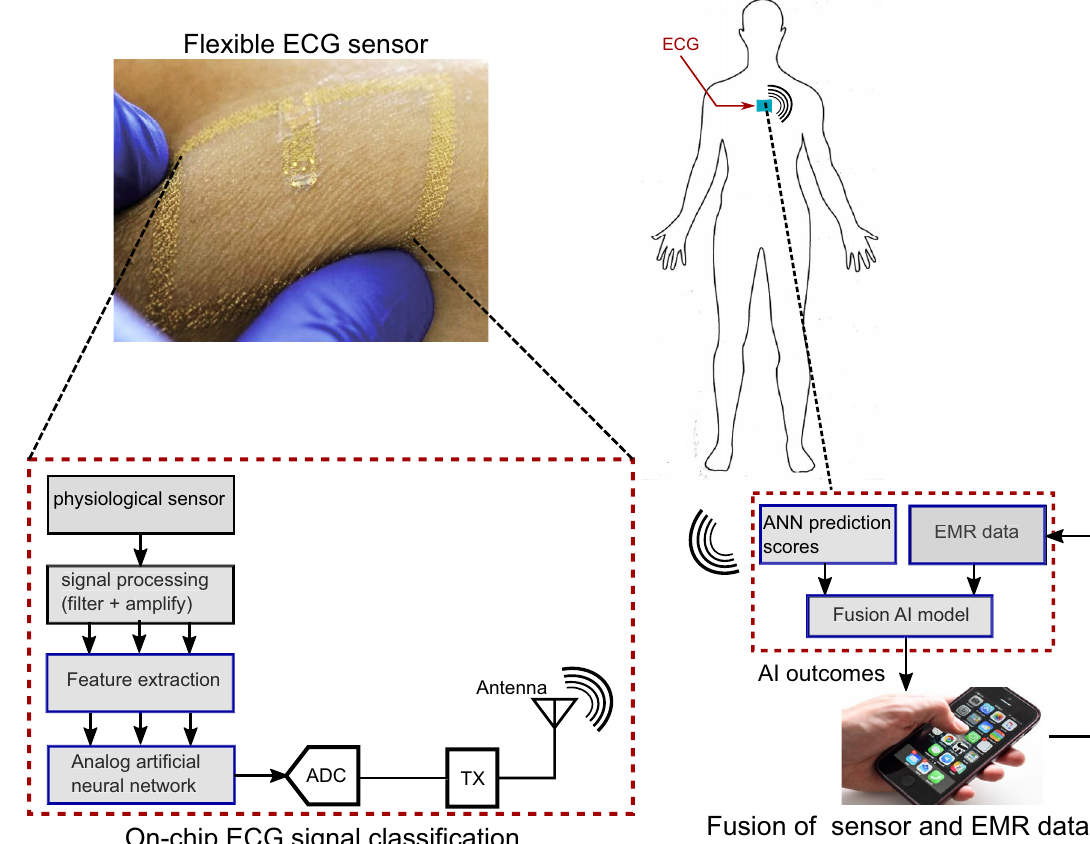
Figure 1. Overview of the proposed paradigm with items outlined in blue representing the tasks in this